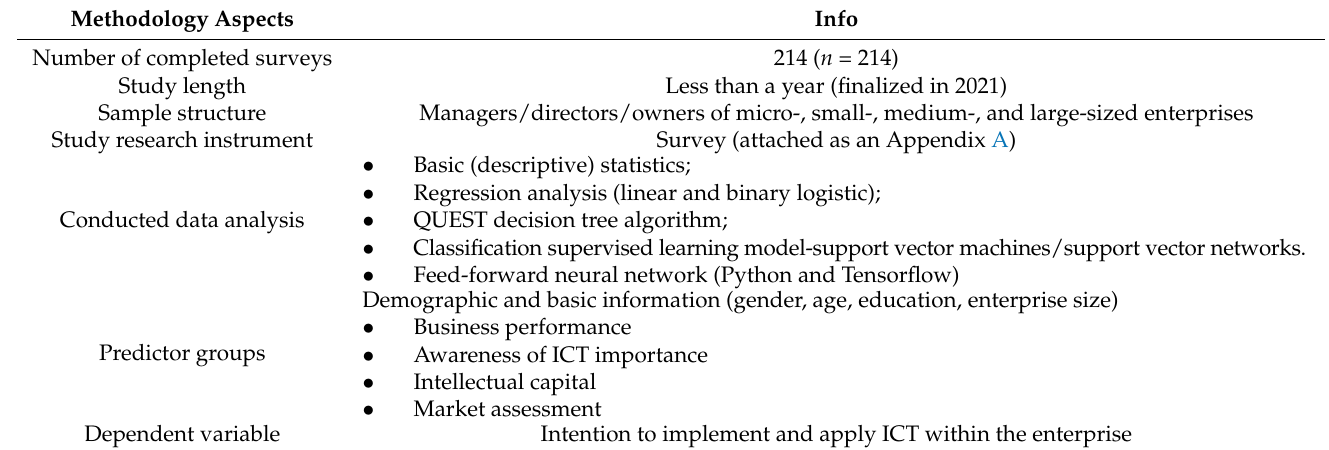
Table 2. Research methodology